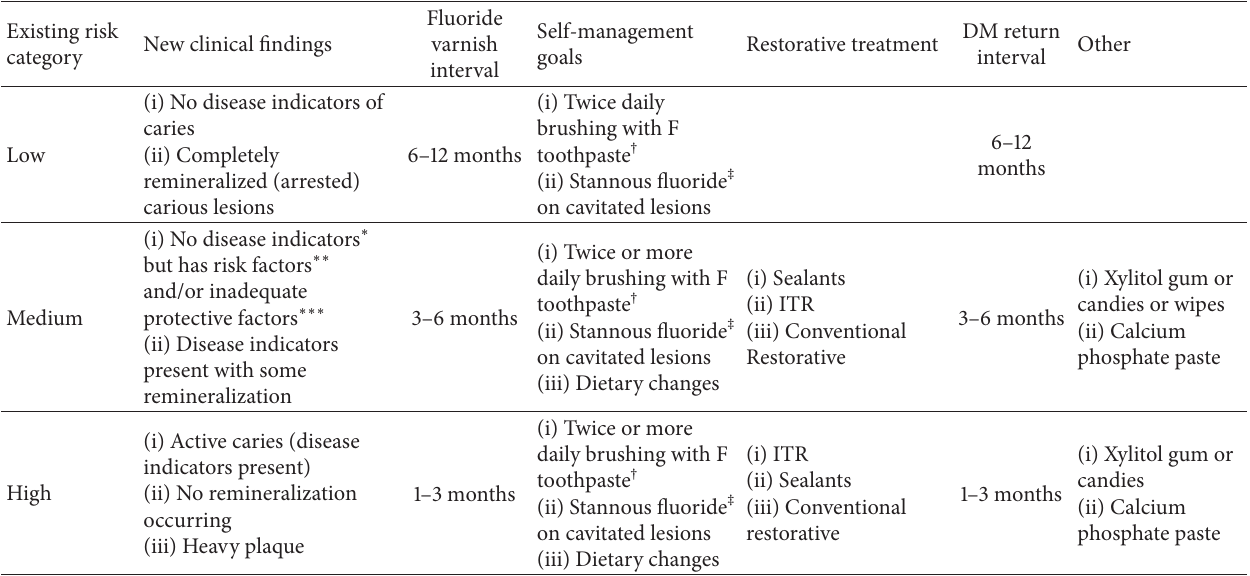
Table 2: ECC Phase 2: disease management